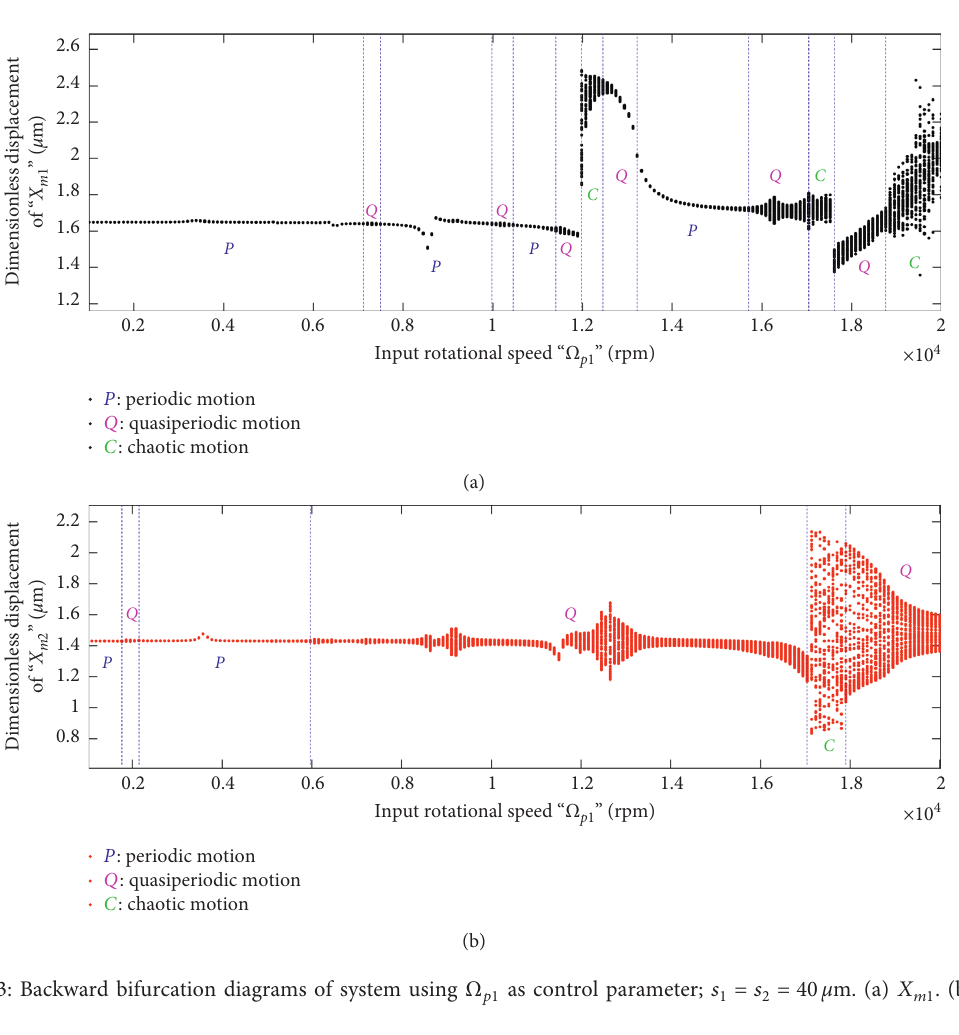
p 1 as control parameter;